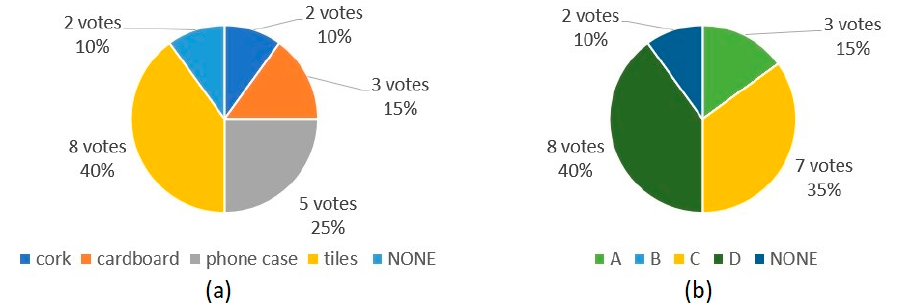
Figure 10. ( a ) Volunteers’ perception of the virtual texture displayed on the touchscreen for test 5. ( b ) Volunteers’ perception about the canvas that better represented the physical texture for test 5. According to survey questions from Appendix A.